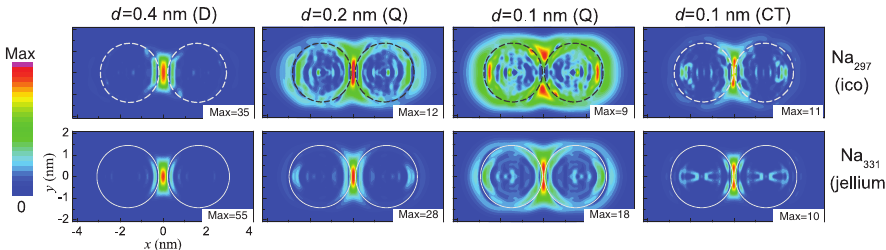
Figure 7: Contour plots of the total electric field amplitude evaluated on the XY plane of the dimer at four selected resonances. Upper row: ico-Na ; lower row: jellium-Na . From left to right: dipolar mode D ( d = 0.4 nm); quadrupole mode Q ( d = 0.2 nm), Q mode ( d = 0.1 nm), 297 331 and CT mode ( d = 0.1 nm). In each panel, the E -field amplitude is normalized to its maximum value, which is also shown as a legend. Figure adapted from Ref. [141].